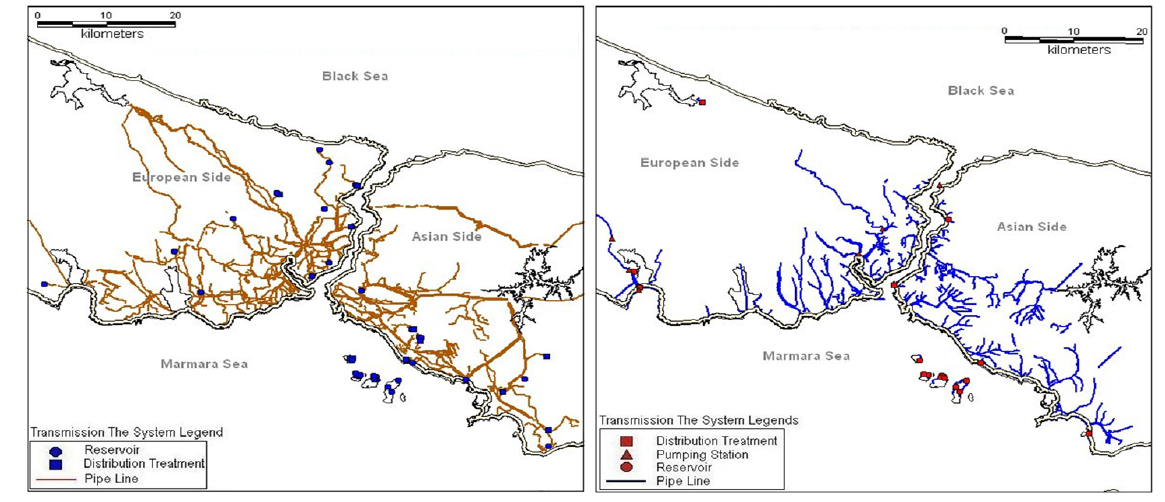
Figure 14. Sanitary water transmission system (left) and waste-water transmission system (right). A uniform, 600m-width buffer zone which corresponds to the maximum inundation distance from the coastline is also shown (modified after KOERI, 2002).